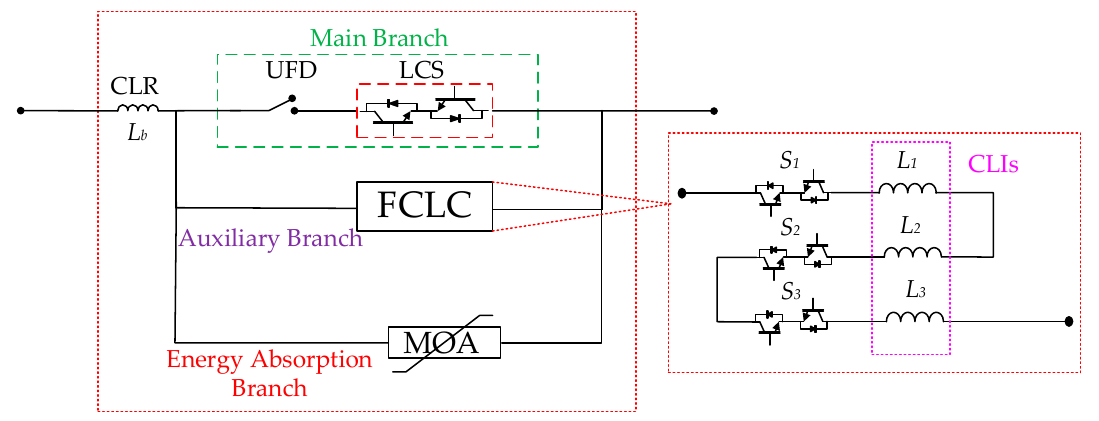
Figure 3. Proposed HCB with FCLC.